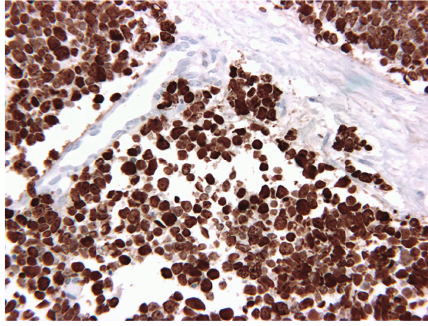
Figure 4: Immunohistochemistry showing strong positivity for Ki- 67, a marker for